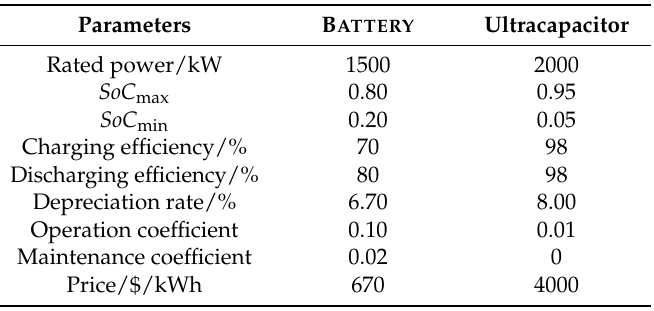
Figure 3. Wind, photovoltaicunit (PV) output and load curve for an isolated microgrid. Table 1. Parameters of the battery and ultracapacitor.